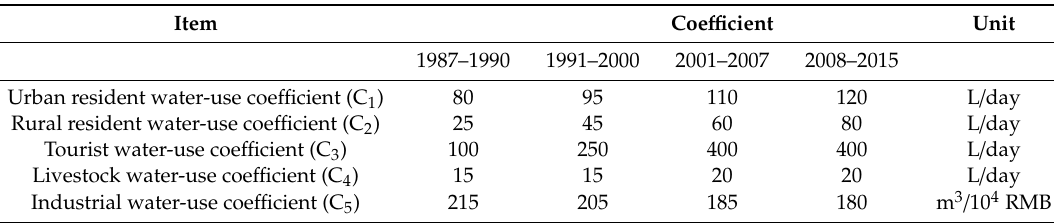
Table 1. Water use coe ffi